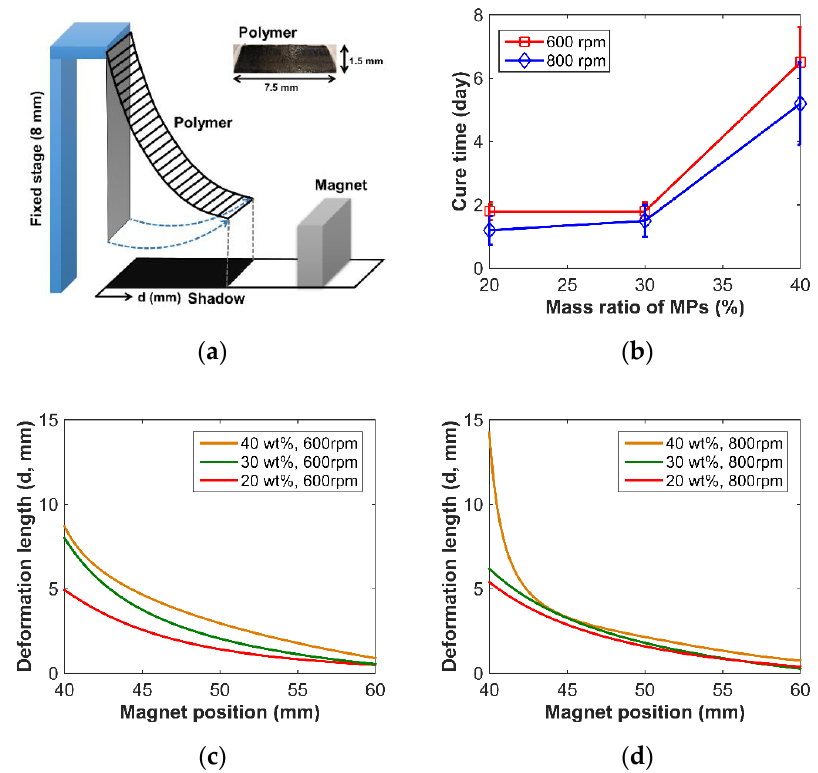
Figure 4. ( a ) Illustration of the test for characterizing the fabricated magnetic polymer. ( b ) Cure time according to the mass ratio of MPs of silicon. ( c , d ) Result of the di ff erence in the shadow length with respect to the magnet position when spin coating speeds of ( c ) 600 rpm and ( d ) 800 rpm are